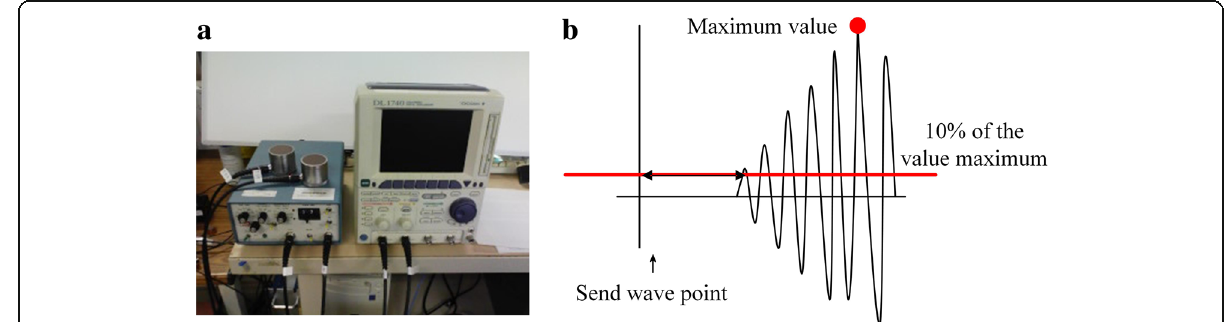
Fig. 1 Experimental system diagram: a measurement system, b Estimation of transit time